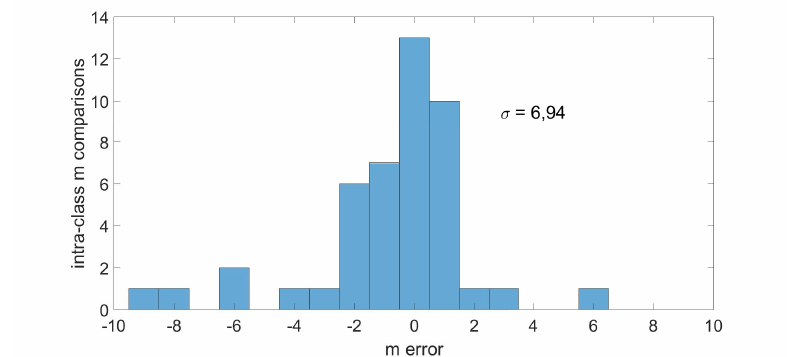
Figure 11. Intra-class PUF ( m ) distribution. Reliability of proposed PUF measured on 16 devices (eight Xilinx Artix and eight Intel Cyclone V) with three PUFs each (48